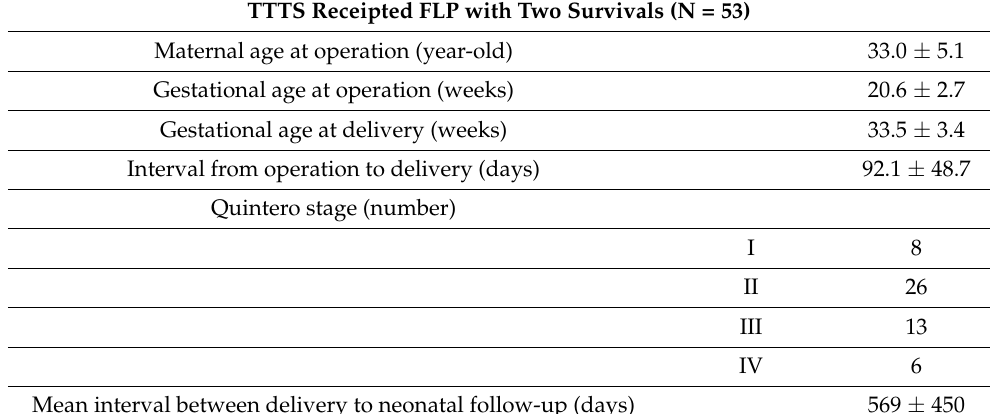
Table 1. Basic characteristics of fetuses with twin–twin transfusion syndrome after fetoscopic laser photocoagulation.